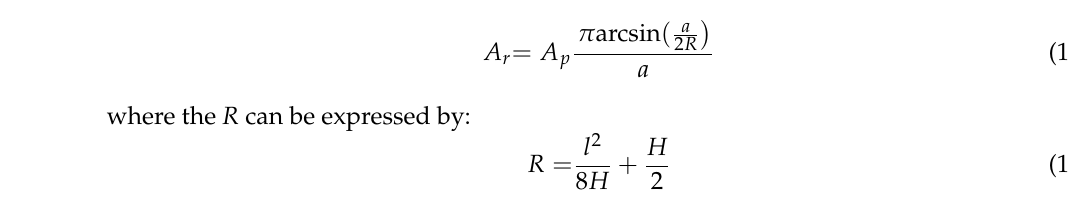
Figure 12. Stress of the membrane in fire conduction (MPa).